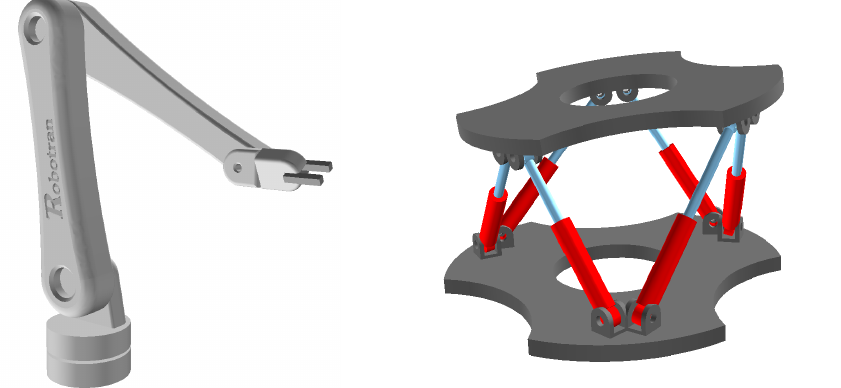
Figure 3. Serial ( left ) versus parallel ( right ) manipulators. Equations (3) or (4) form a DAE system, as they are made of differential and